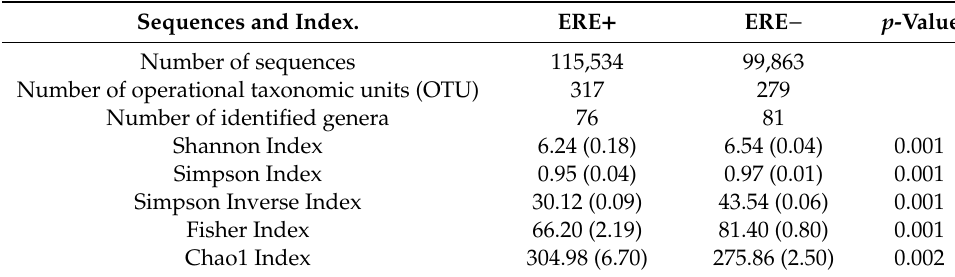
Table 3. Summary of sequences identified and comparison of microbial diversity indices in rabbit cecal contents of animals with and without ERE. ERE + : Rabbits positive for epizootic enteropathy. ERE − : Healthy rabbits.